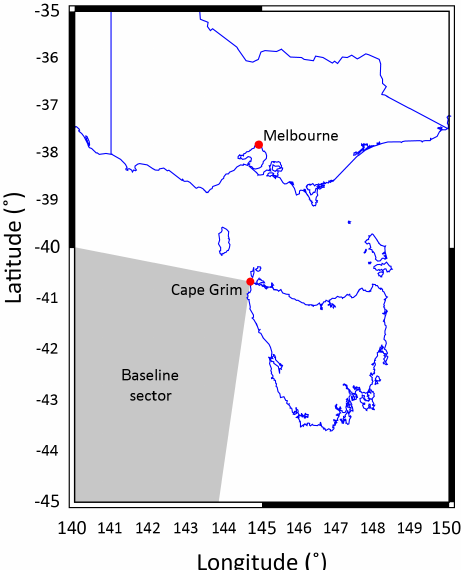
Figure 1. Map of south-eastern Australia and Tasmania, showing the location of the Cape Grim Baseline Air Pollution Station (CG- BAPS) and clean air “baseline”